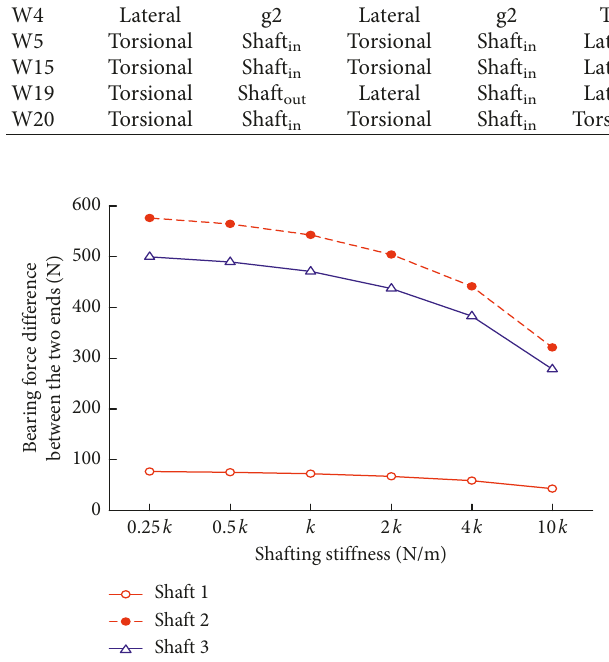
Figure 22: Effect of stiffness of transmission shaft on the imbal- anced force at two ends of